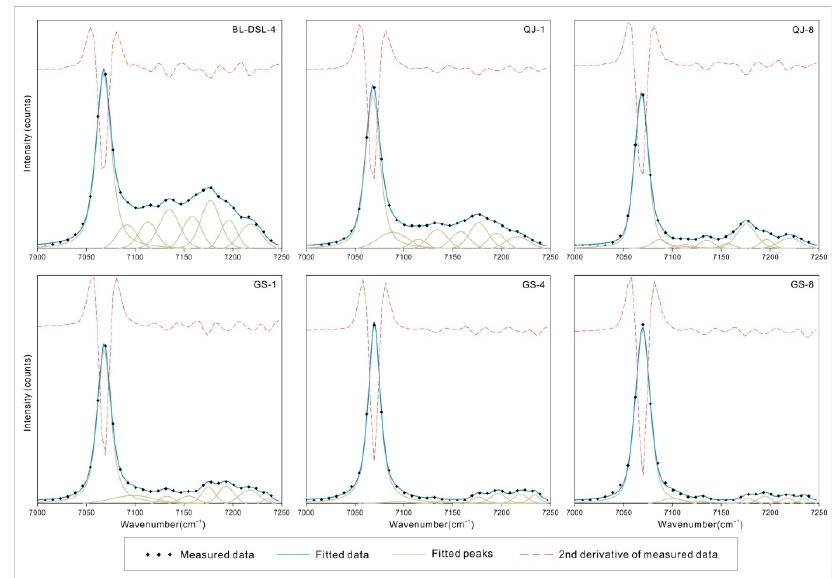
Figure 8. NIR spectral component analysis of the OH stretching overtone bands.